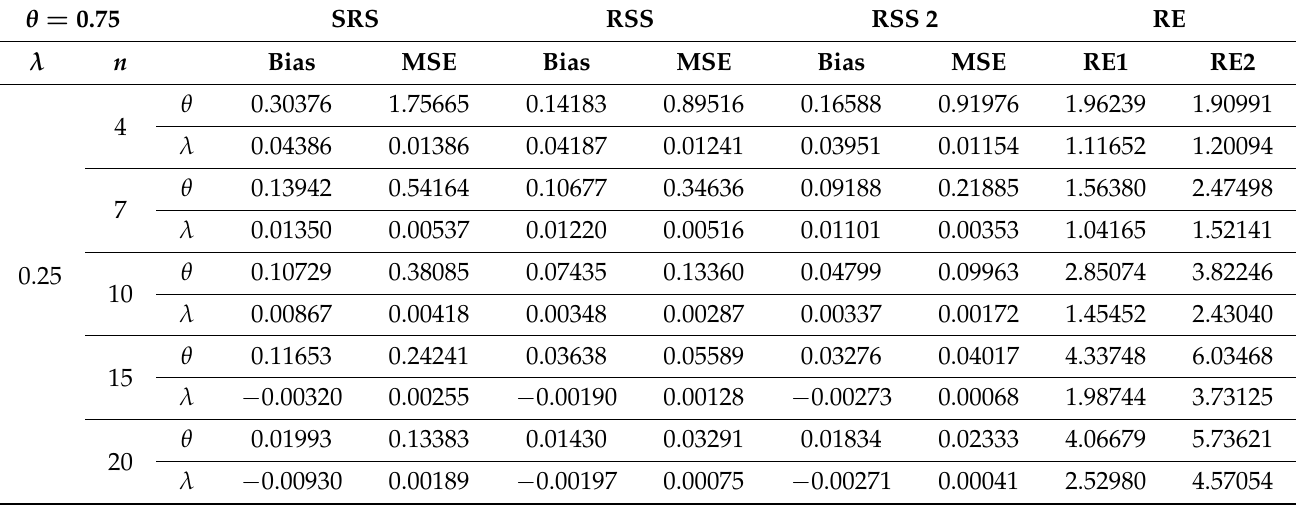
Table 4. Bias, MSE, and RE for the GB( θ , λ ) distribution under the SRS and RSS schemes when θ =